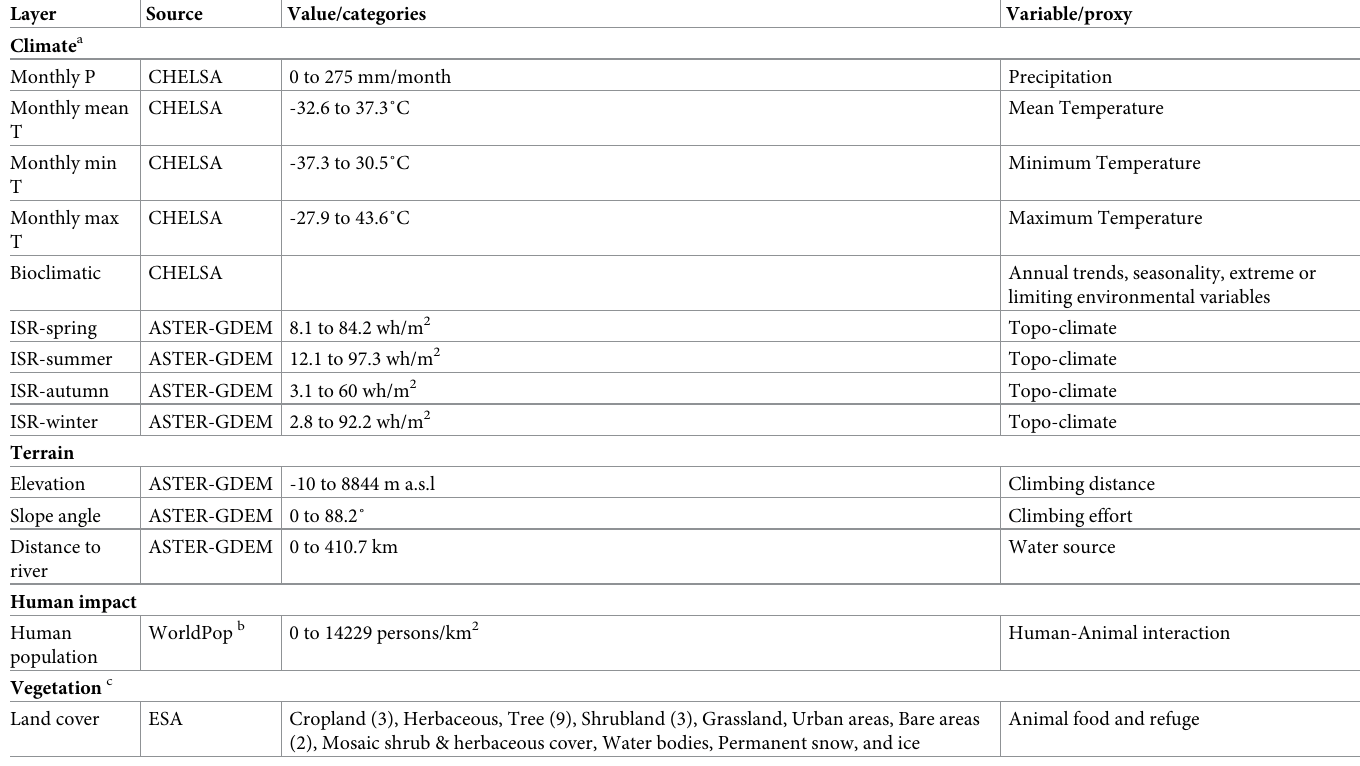
Table 1. Data layer and source, raster/vector, value range/categories (number of subcategories in brackets) and specification of the unit of measurement/impact